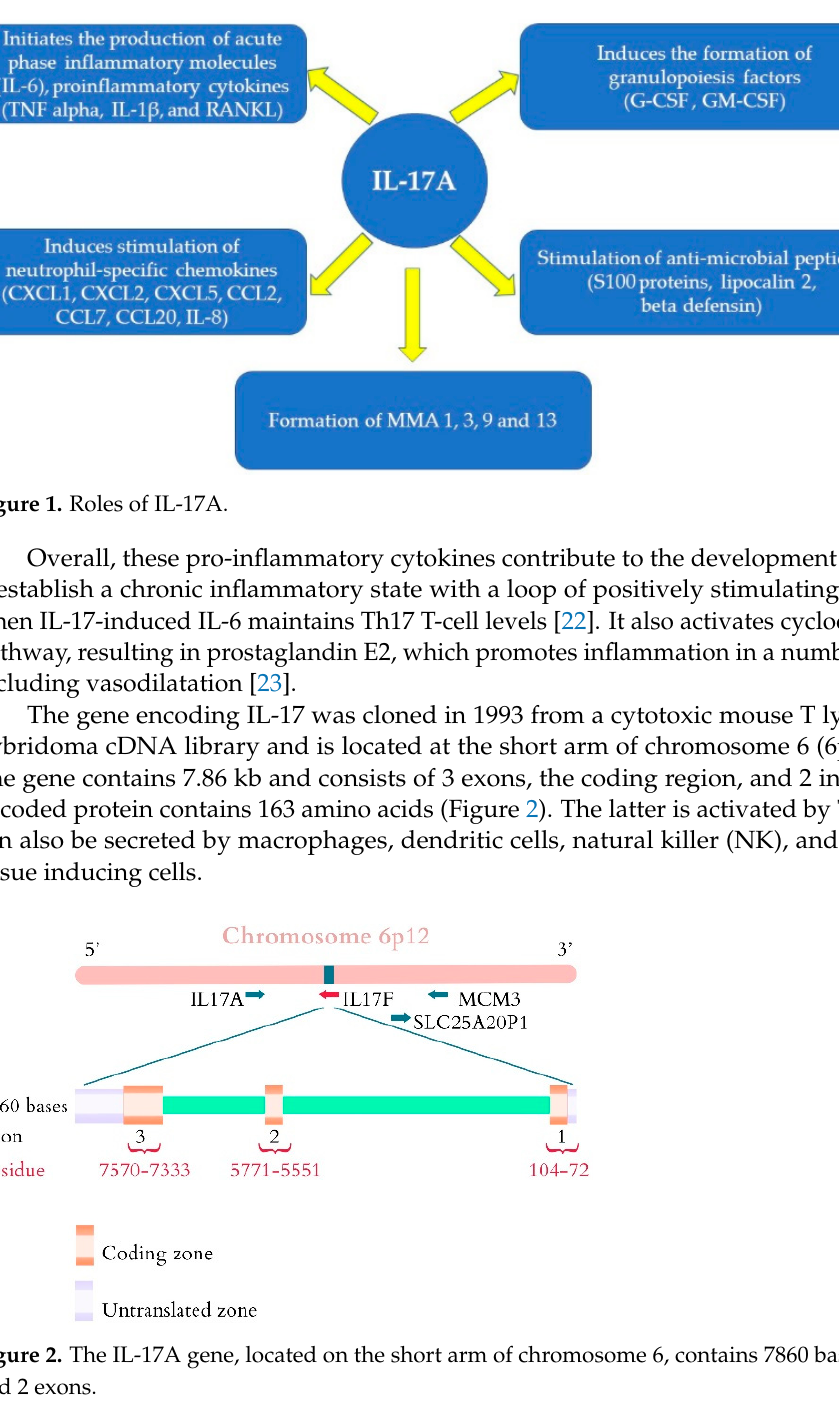
Figure 2. The IL-17A gene, located on the short arm of chromosome 6, contains 7860 bases, 3 exons, and 2 exons.